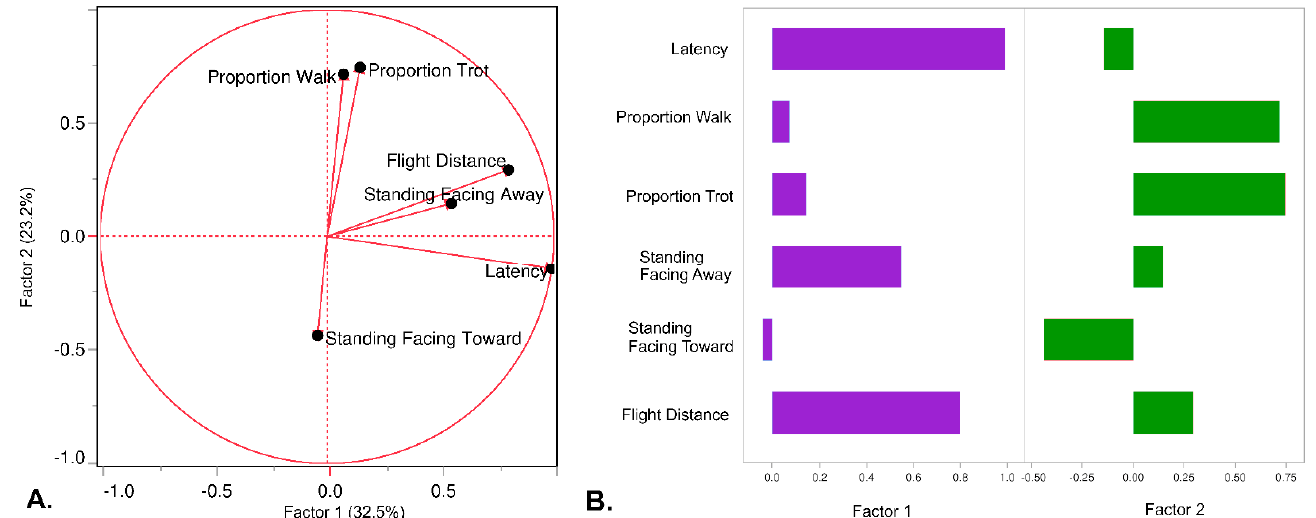
Figure 2. ( A ) The six behavioral variables detected using an ethogram were collapsed into two primary factors using PCA followed by rotation. ( B ) Two factors characterize behavioral traits such as “fearfulness” in Factor 1 and “activity” for Factor 2. Horses with a high Factor 1 score displayed a larger flight distance and took longer to return to the pan. In contrast, horses with a high Factor 2 score walked and trotted more frequently while in the pen.